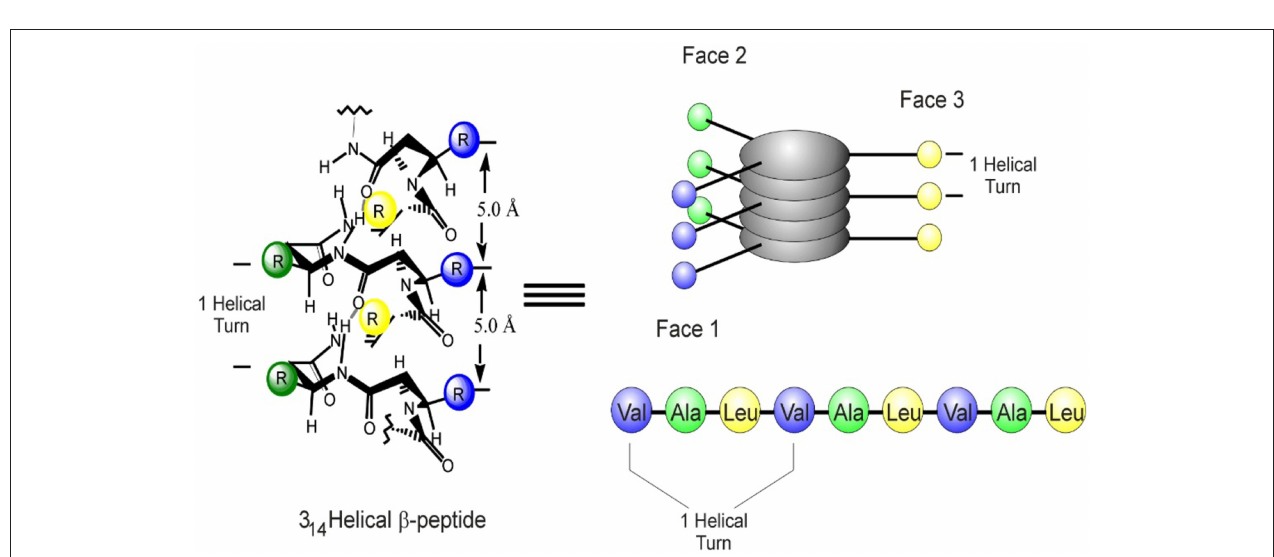
FIGURE 2 | Structure and geometry of a β 3 -peptide 14-helix with the longitudinal alignment of amino acid side chains on the helical surface resulting in a topology that mediates the formation of peptide bundles or for binding to specific